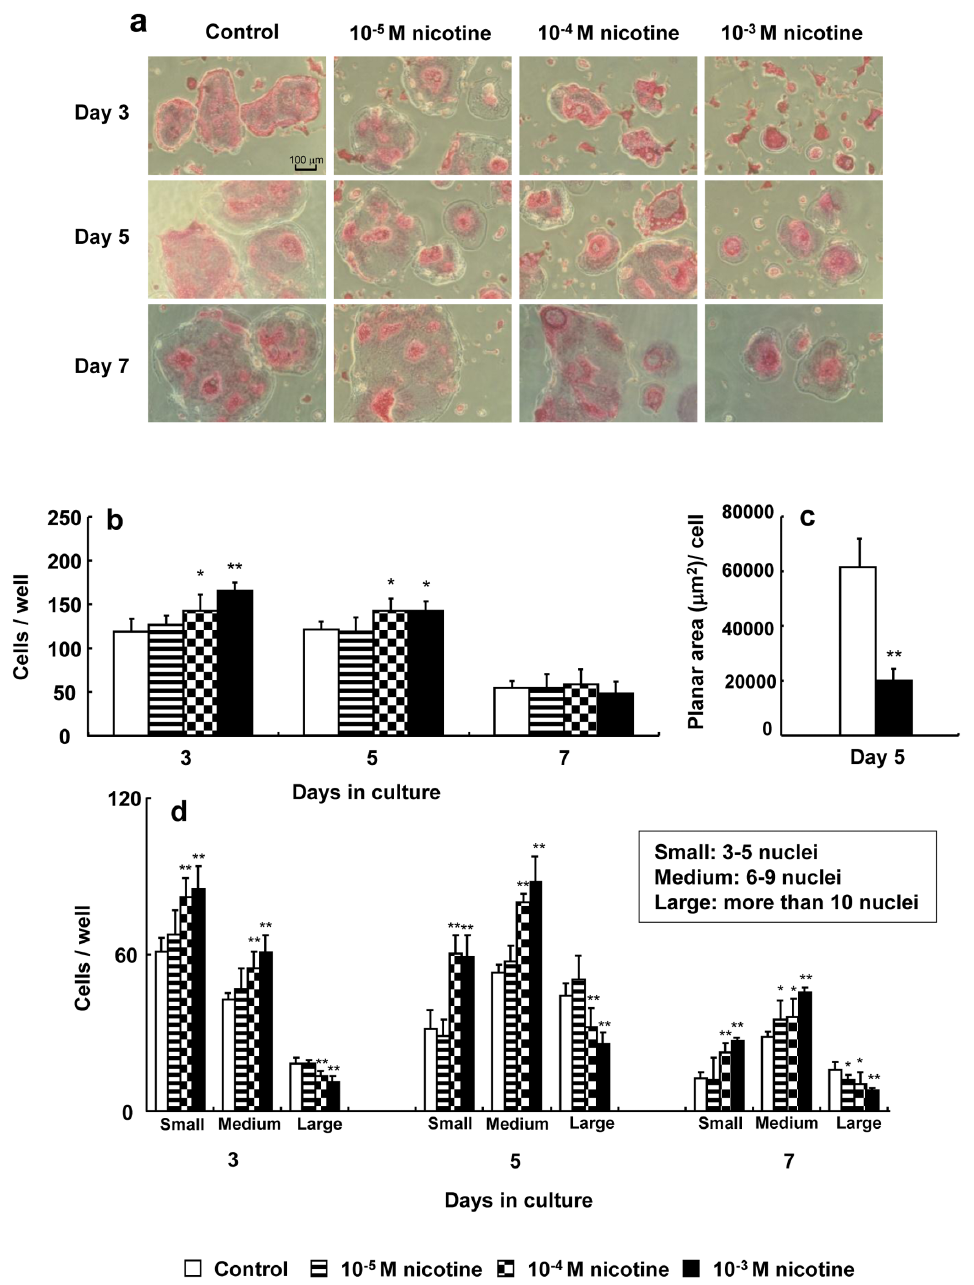
Figure 2. Effect of nicotine on tartrate-resistant acid phosphatase (TRAP) staining of osteoclasts. RAW264.7 cells were cultured in differentiation medium with 0 (control), 10 2 5 , 10 2 4 , or 10 2 3 M nicotine for up to 7 days, and then were stained using a TRAP staining kit on days 3, 5, and 7 of culture (original magnification, 6 100) (a). TRAP-positive cells with more than three nuclei were counted under a phase-contrast microscope on days 3, 5, and 7 of culture. Data are shown as the mean 6 S.D., n=3 independent experiments, each performed using quintuplicate wells. *p , 0.05, **p , 0.01, nicotine treatment vs. control (b). The cells were quantified by tracing the perimeter of each osteoclast to obtain the mean planar cell area under each condition on day 5 of culture. The histogram shows the average planar area of osteoclasts under the control or 10 2 3 M nicotine condition. Data are expressed as the mean 6 S.D., n=3 independent experiments, each performed using quintuplicate wells with five randomly selected osteoclasts analyzed per well. * *p , 0.01 compared with control (c). TRAP-positive cells with small (3–4 nuclei), medium (5–9 nuclei) and large (greater than 10 nuclei) were counted under a phase-contrast microscope on days 3, 5, and 7 of culture. Data are shown as the mean 6 S.D., n=3 independent experiments, each performed using quintuplicate wells. *p , 0.05, **p , 0.01, nicotine treatment vs. control (d).